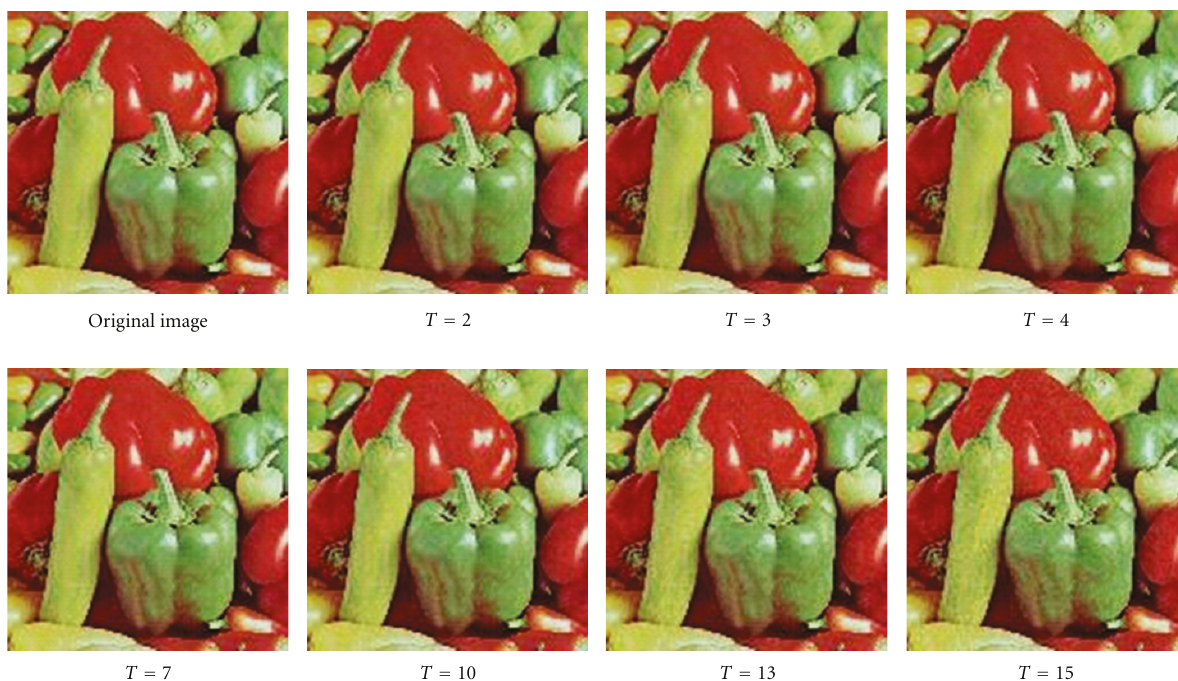
Figure 6: The original peppers image and the stego-images with di ff erent distance